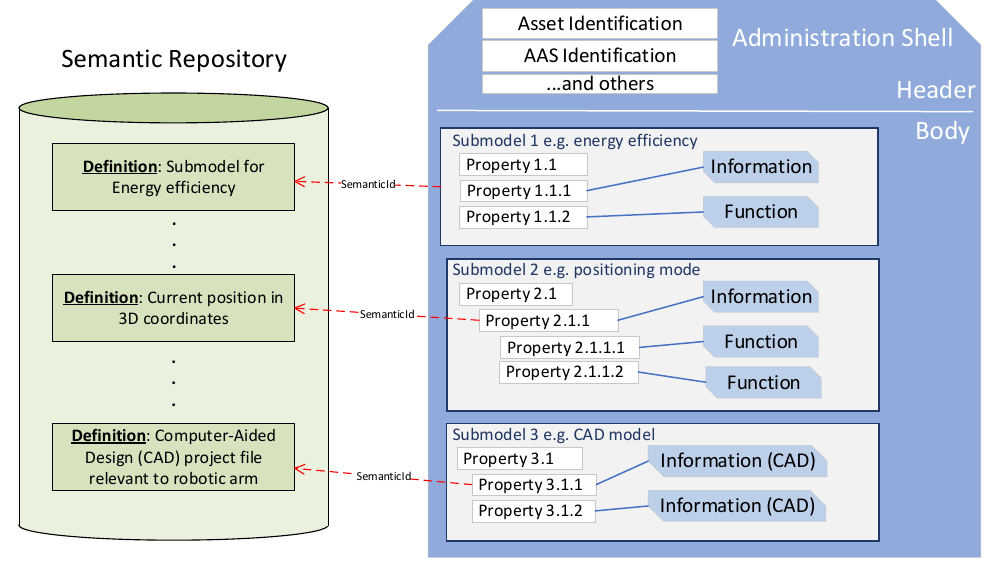
Figure 1. Structure of an Asset Administration Shell (AAS) from a high-level point of view.